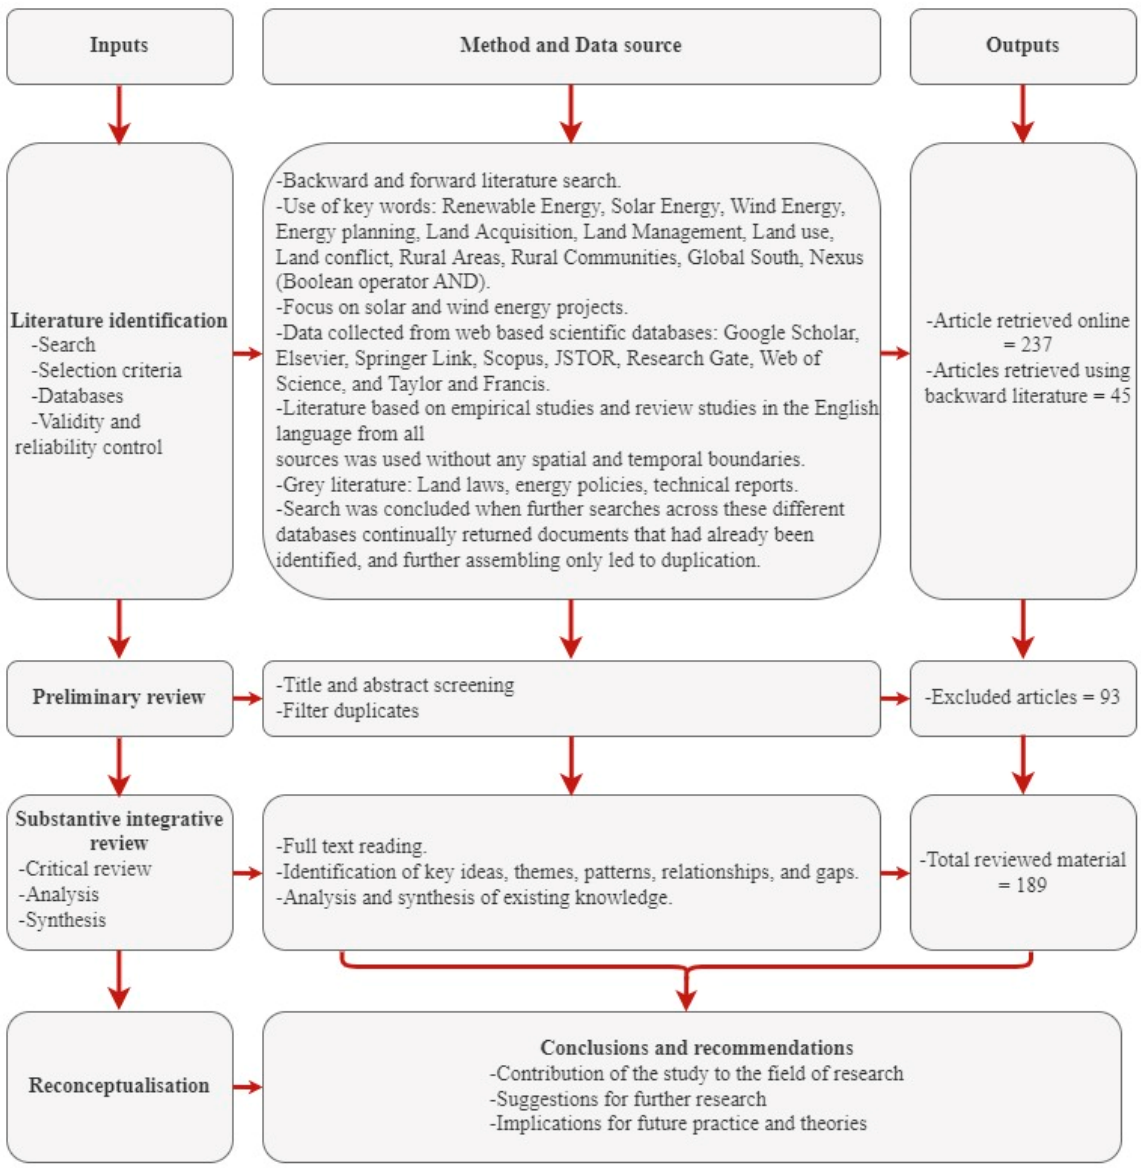
Figure 1. Research process and design overview.